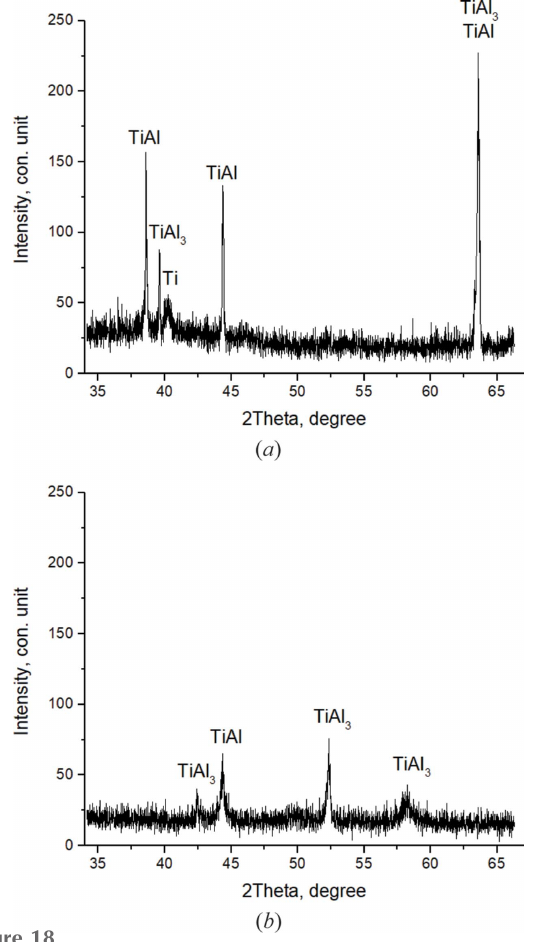
Figure 18 Diffractograms of the 43rd ( T = 1352.5 (cid:3) C) ( a ) and the 60th ( T = 1118.6 (cid:3) C) ( b ) shots.